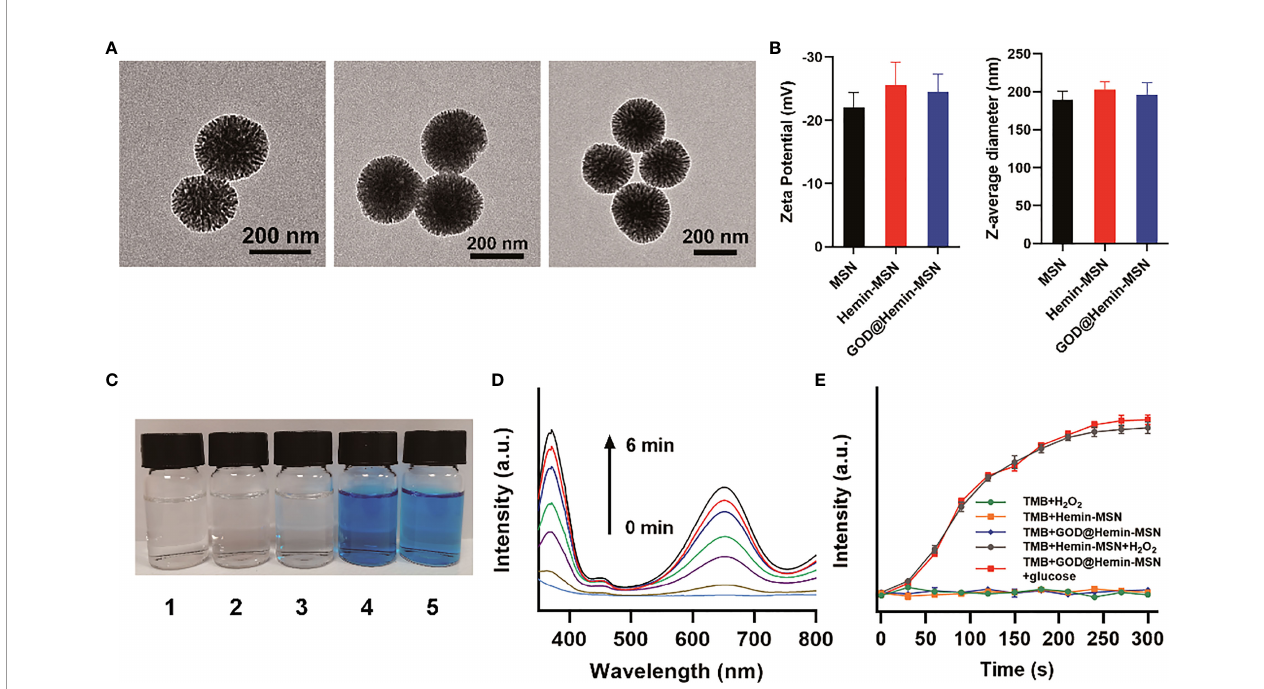
FIGURE 1 | Characterization. (A) TEM images of mesoporous silica nanospheres (MSN), hemin-MSN, and MSN decorated with hemin and glucose oxidase (GOD@Hemin-MSN) ( from left to right ). (B) Zeta potential and Z -average diameter measurements of MSN, hemin-MSN, and GOD@Hemin-MSN. (C) Images of the reaction of 3,3 ′ ,5,5 ′ -tetramethylbenzidine (TMB) solution (0.1 mM) to ( 1 ) H 2 O 2 , ( 2 ) hemin-MSN, ( 3 ) GOD@Hemin-MSN, ( 4 ) hemin-MSN+H 2 O 2 , and ( 5 ) GOD@Hemin- MSN+glucose. (D) UV – vis spectra of the reaction of TMB solution to GOD@Hemin-MSN+glucose with time variation. (E) Time-dependent changes of the absorbance of TMB solution at 652 nm with various